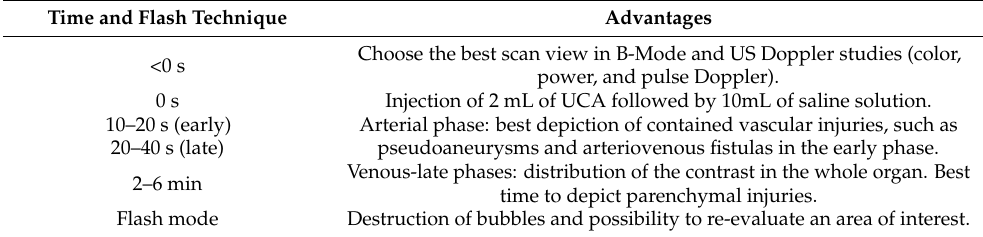
Table 1. US scanning time after UCAs administration and flash mode technique.